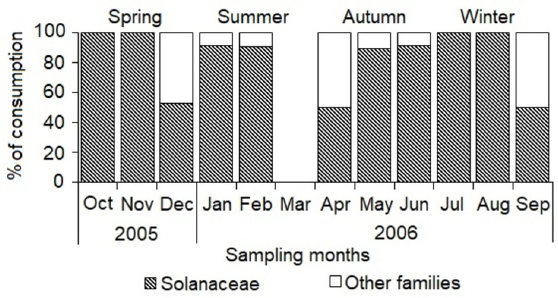
Figure 1. Seasonal percentage of consumption (number of fecal samples with seeds) of Solanaceae and other families in the diet of S. lilium .